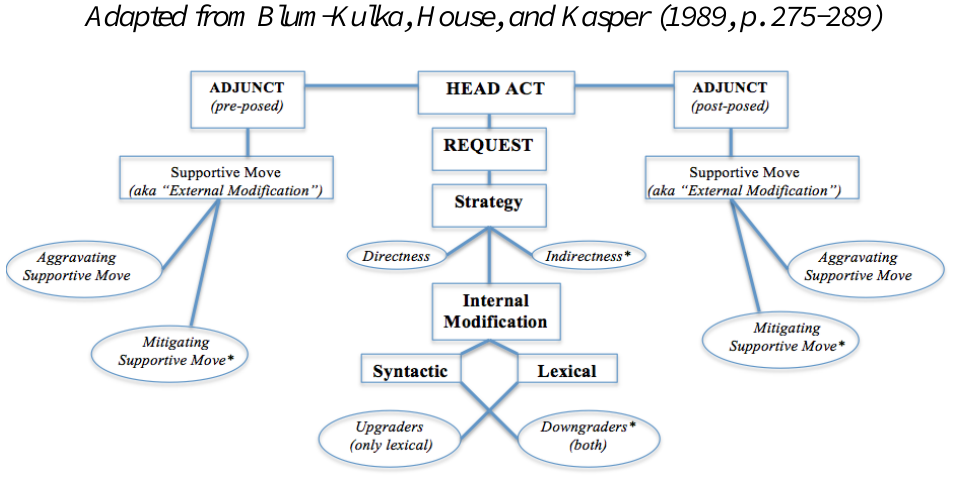
The Components of the speech act of Requests Adapted from Blum-Kulka, House, and Kasper (1989, p.